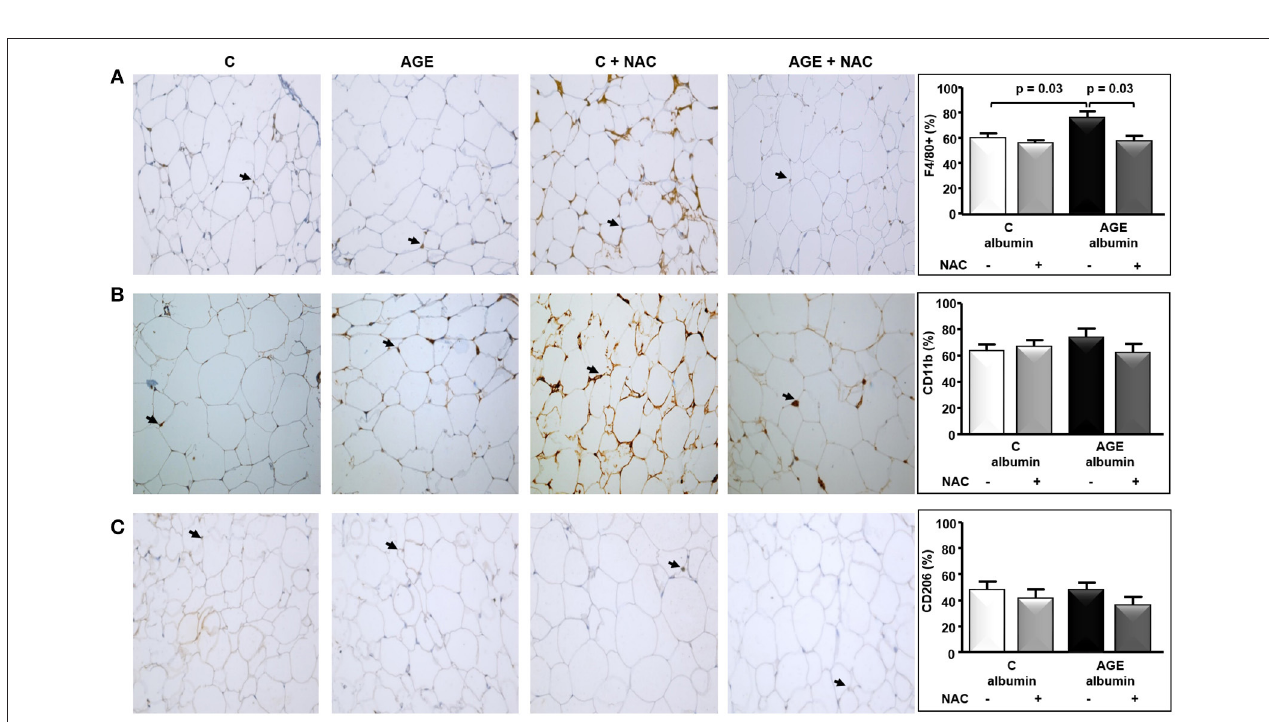
FIGURE 3 | Periepididymal adipose tissue morphology. Periepididymal fat from animals treated with C-albumin ( n = 8), C-albumin + NAC ( n = 7), AGE- albumin ( n = 8), and AGE-albumin + NAC ( n = 7) was excised and weighed to calculate its relative mass (A) . Adipocyte number per µ m 2 (B) was estimated by stereological method (counting-points). Results (mean ± SEM) were compared by One-way ANOVA with Newman-Keuls post-test.